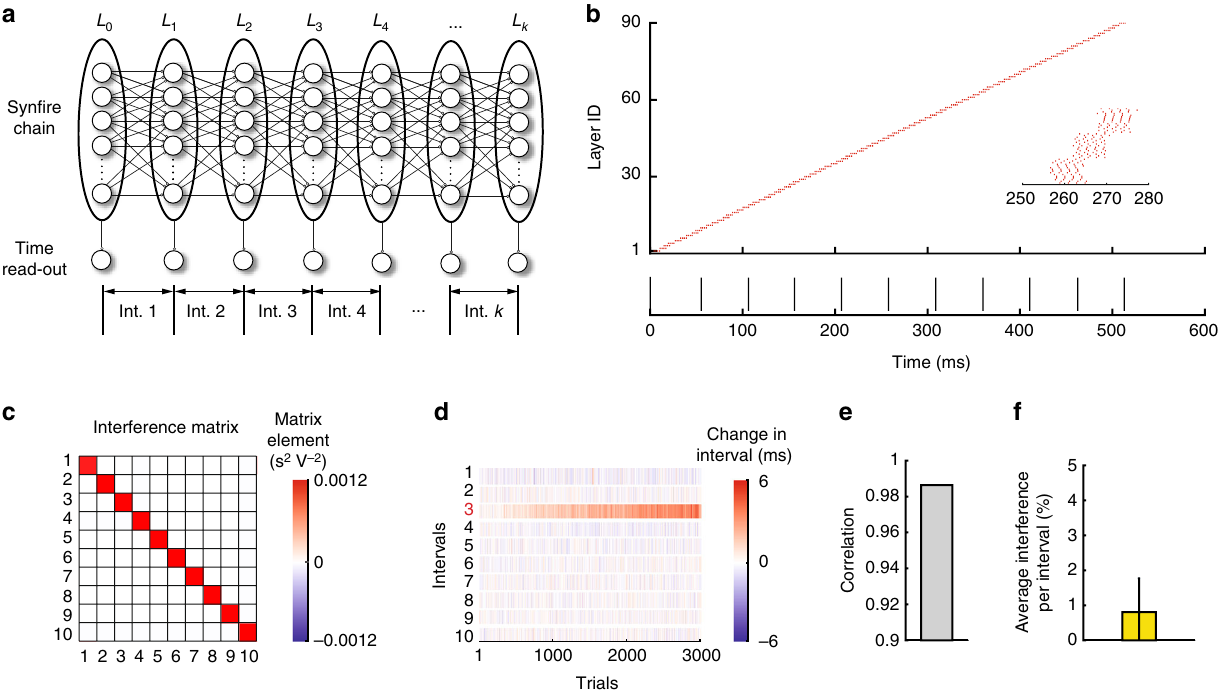
Fig. 5 Flexible timing with biologically plausible syn fi re chains. a Schematic showing the network architecture and interval (Int.) time readout. b Example run of the syn fi re chain. Only one neuron per layer is shown. On the bottom is the activity of the read-out neurons that de fi ne the interval boundaries. c The interference matrix of the syn fi re chain. d Examples of a reinforcement learning ‘ experiment ’ that targeted interval 3 for lengthening. The effect on all intervals after 3000 trials is shown. e Correlation coef fi cient between the interval changes calculated from the interference matrix and from the reinforcement learning simulations (as in Fig. 2i). f Average interference per interval in reinforcement learning simulations, averaged across 20 learning simulations. Error bar shows standard deviation across